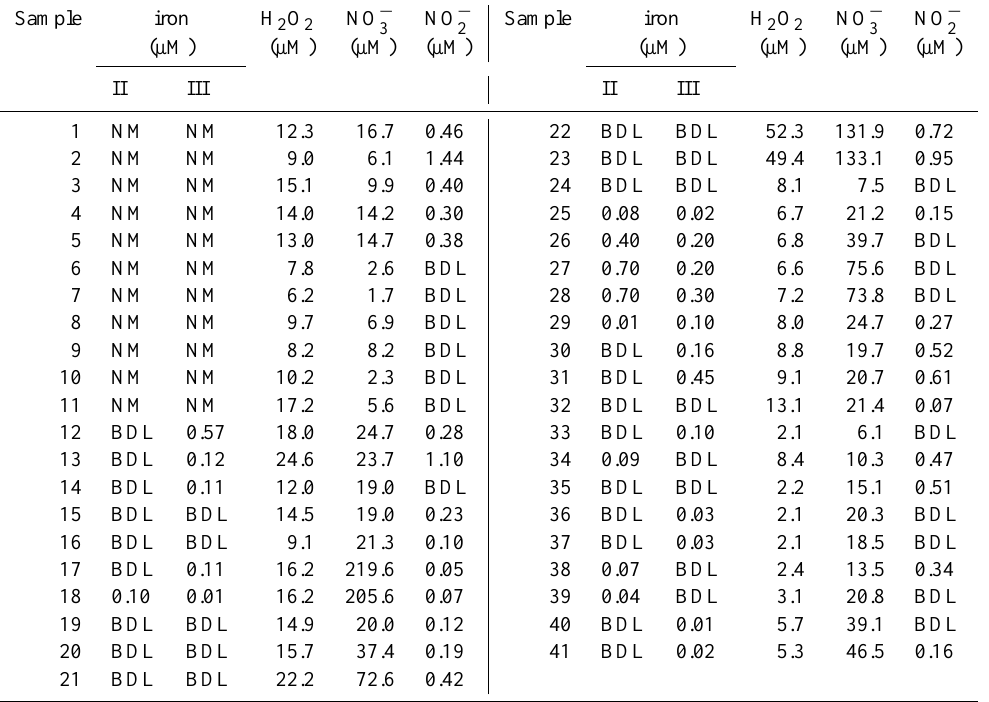
Table 1. Concentration of main sources of hydroxyl radical in sampled clouds. A total of 41 samples have been analysed. BDL: below ) . NM: not detection limit (0.01µM for iron and 0.05µM for NO − 2